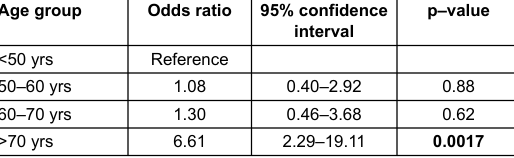
Table 6: Odds ratio for urinary retention by age